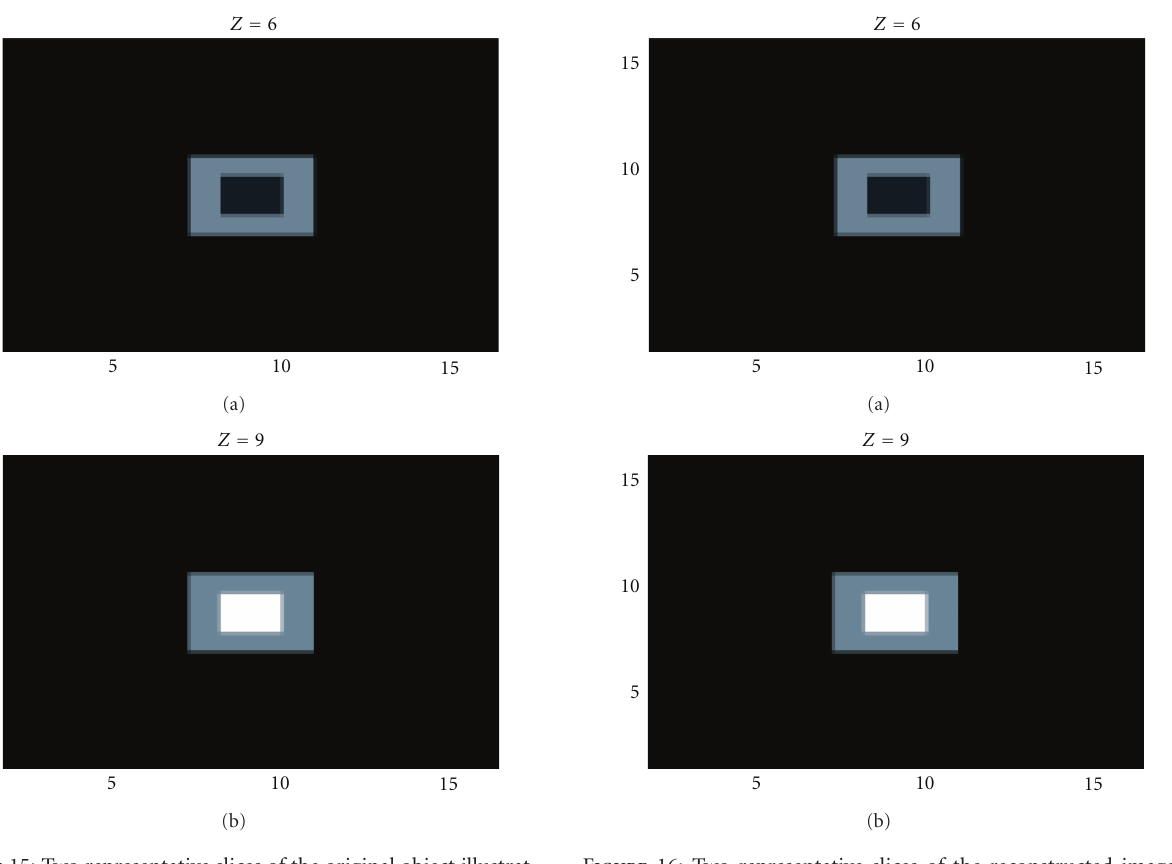
Figure 16: Two representative slices of the reconstructed images corresponding to the object shown in Figure 15 (reprinted with permission from